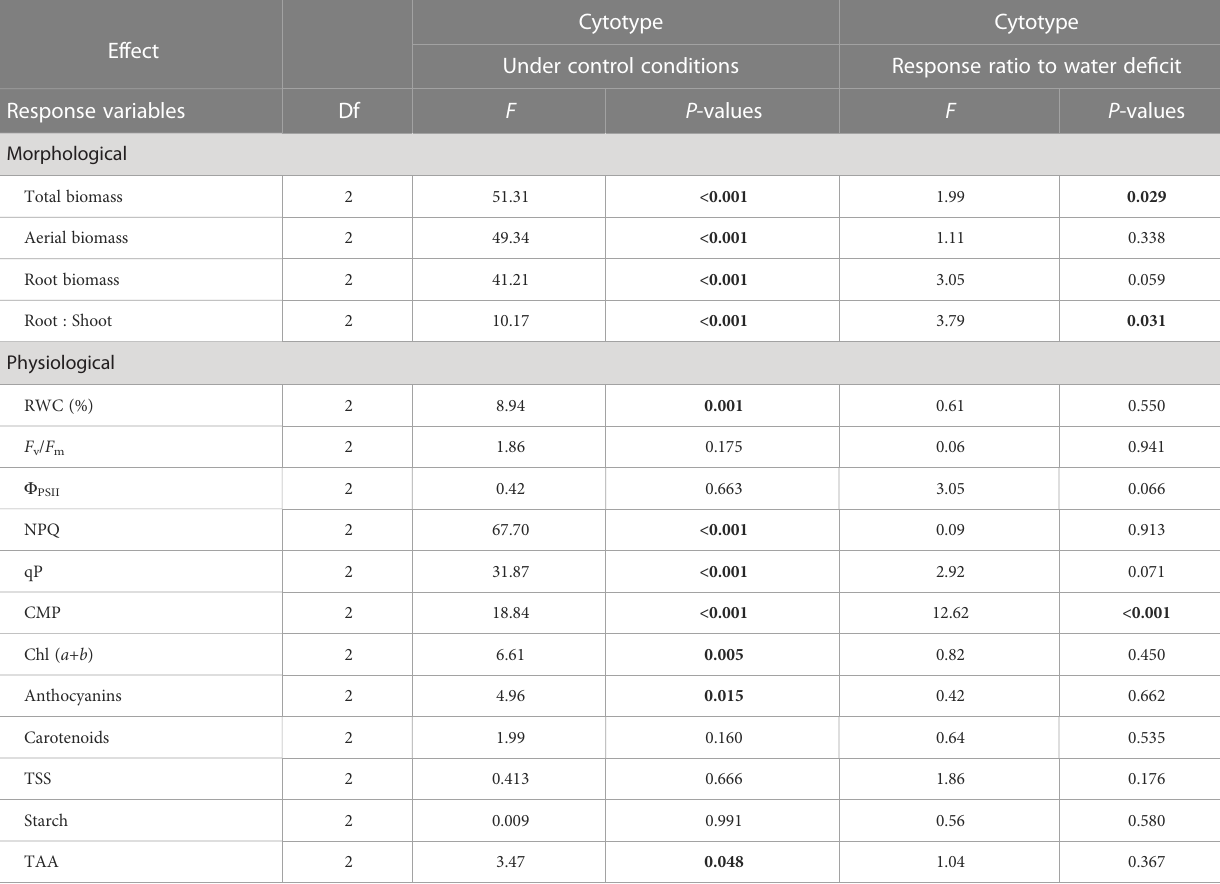
Signi fi cant P values (P < 0.05) are highlighted in CMP (Table 2), and a marginally non-signi fi cant effect for root